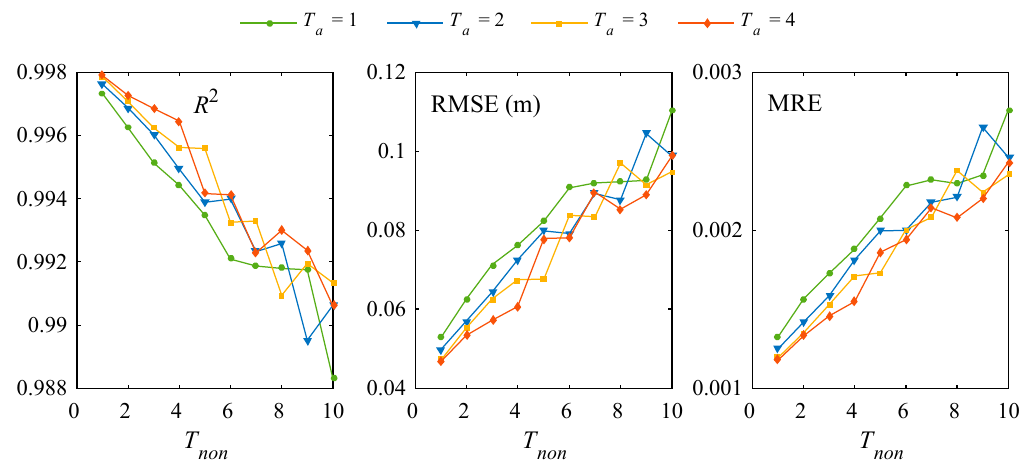
Figure 15. SVR+UKF performance under different assimilation/non-assimilation cycles at Xiaohezui.